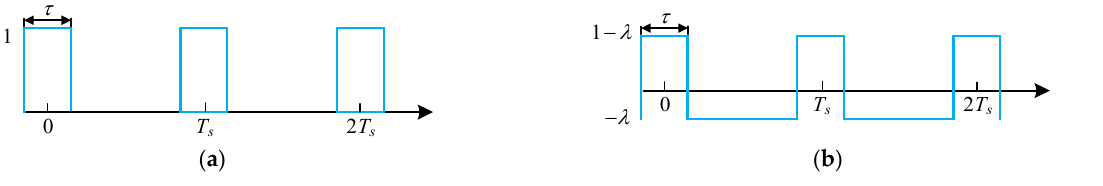
Figure 2. Amplitude modulation function: ( a ) Amplitude modulation function p ( t ); ( b ) Amplitude modulation function p −λ ( t ).